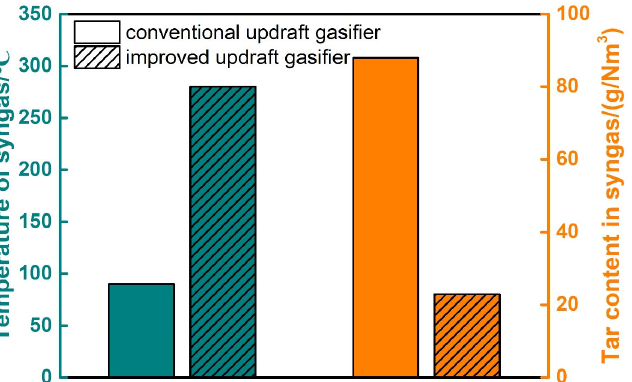
Figure 5. Comparison between conventional and improved updraft gasifier for the corn stalk.